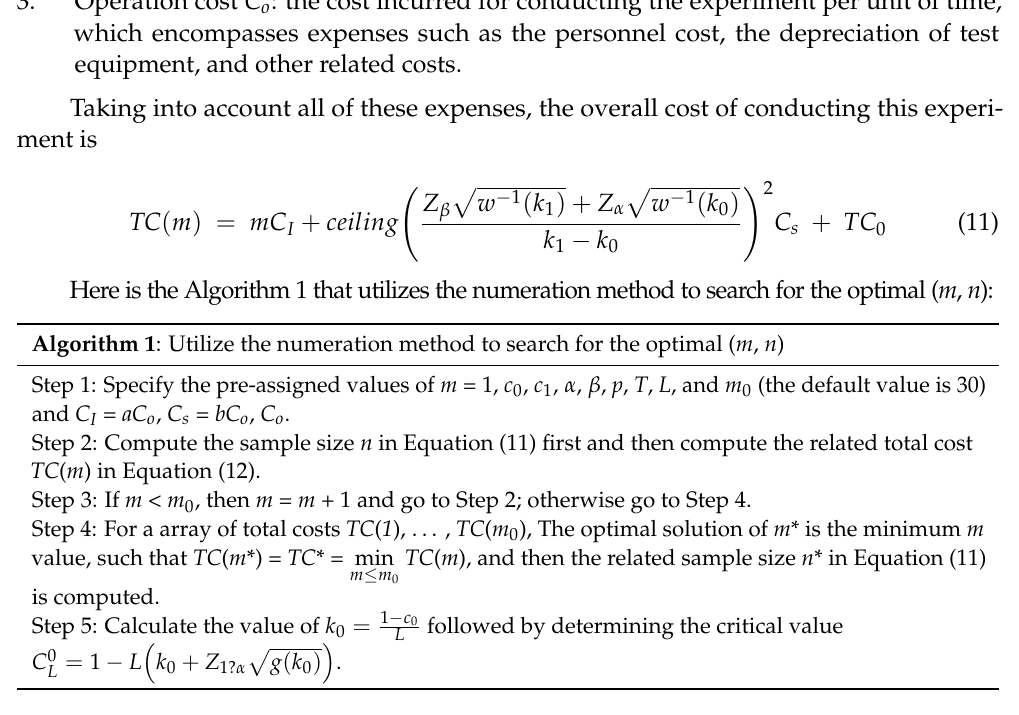
Algorithm 1 : Utilize the numeration method to search for the optimal ( m , n )